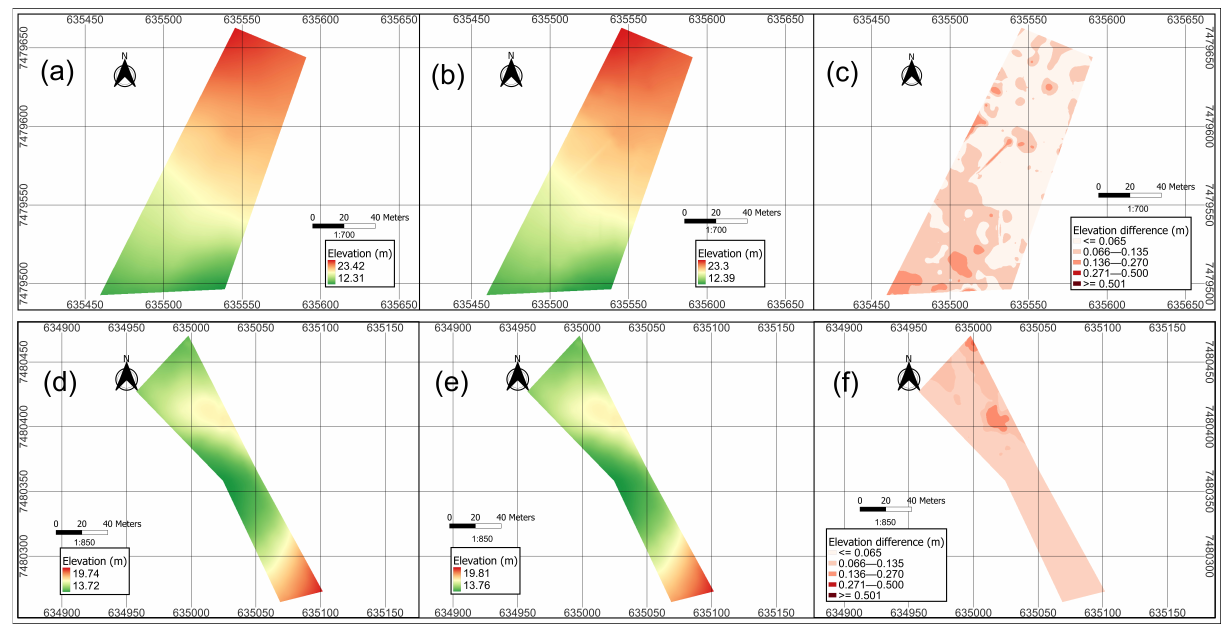
Figure 13. DEMs for areas 3 and 4 and the differences of DEM from both methodologies: ( a ) DEM of area 3, obtained by conventional topographic survey; ( b ) DEM of area 3, obtained using RPA; ( c ) altimetric difference between DEMs ( a , b ). ( d ) DEM of area 4, obtained by conventional topographic survey; ( e ) DEM of area 4, obtained using RPA; ( f ) altimetric difference between DEMs ( d,e ).